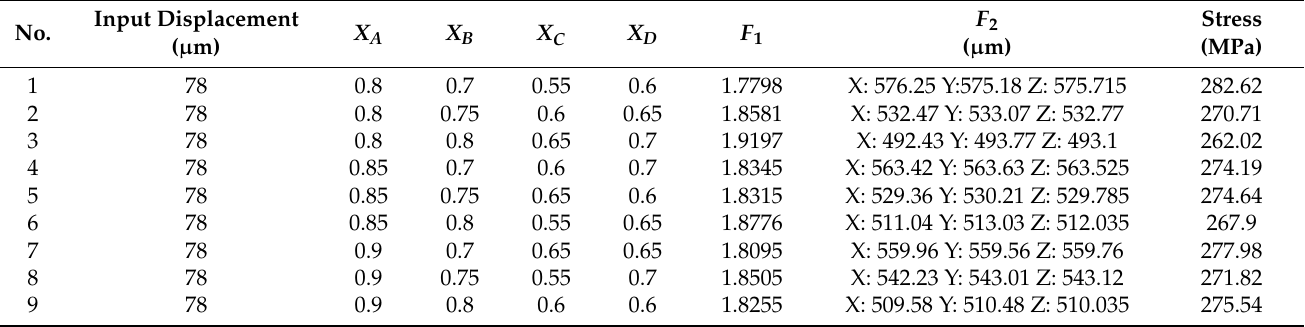
Table 3. Numerical results (Input displacement of 78 µ m).